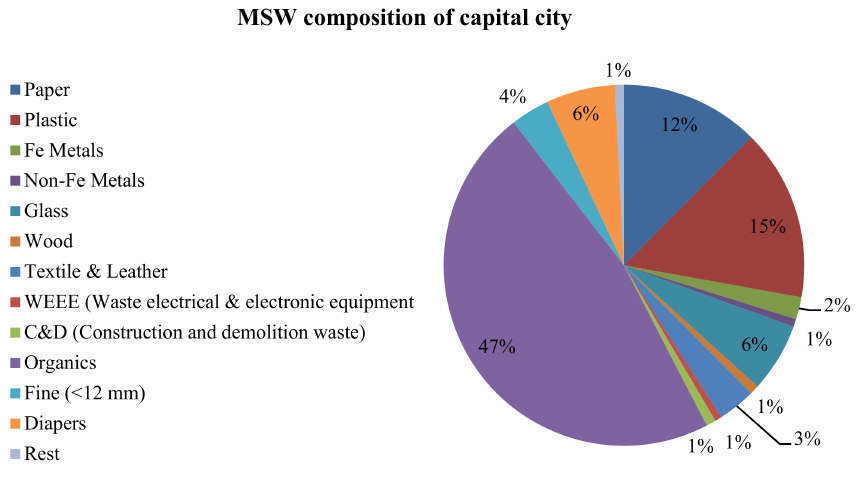
Figure 1. Average municipal solid waste (MSW) composition of Nur-Sultan city in